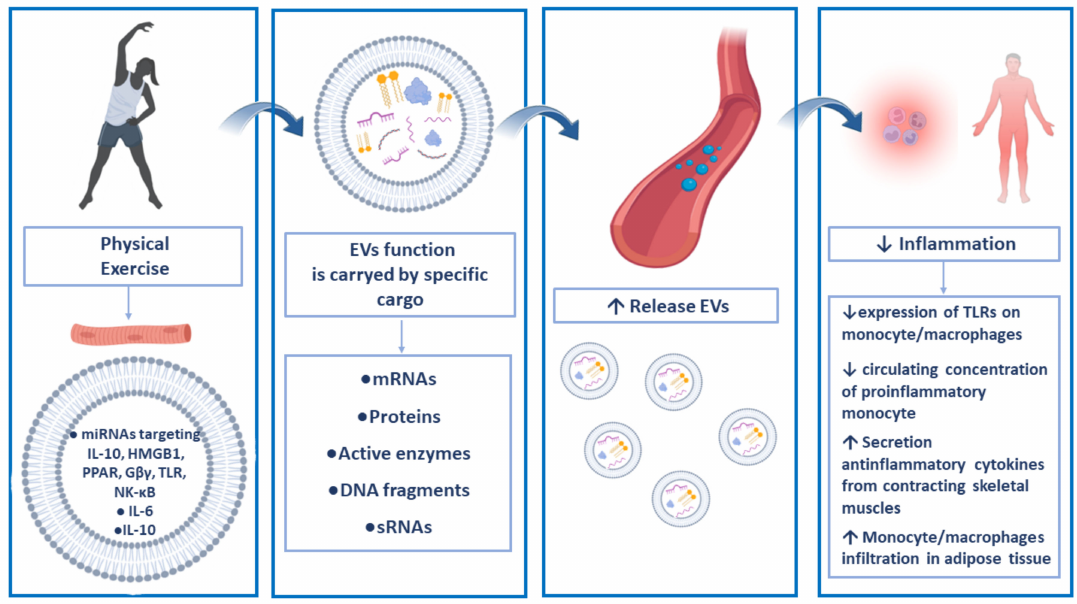
Figure 1. Physical exercise and anti-inflammatory effects of EVs. Physical exercise induces the release of EVs of different origins. It has been demonstrated that exercise training induces the secretion of EVs stemming from skeletal muscle cells that carry anti-inflammatory signaling molecules (miRNAs and cytokines). Once released, (leukocyte-, muscle-, and platelet-derived EVs) EVs act locally and systemically reaching target tissues throughout blood circulation. EVs produced by physical exercise therefore act as anti-inflammatory